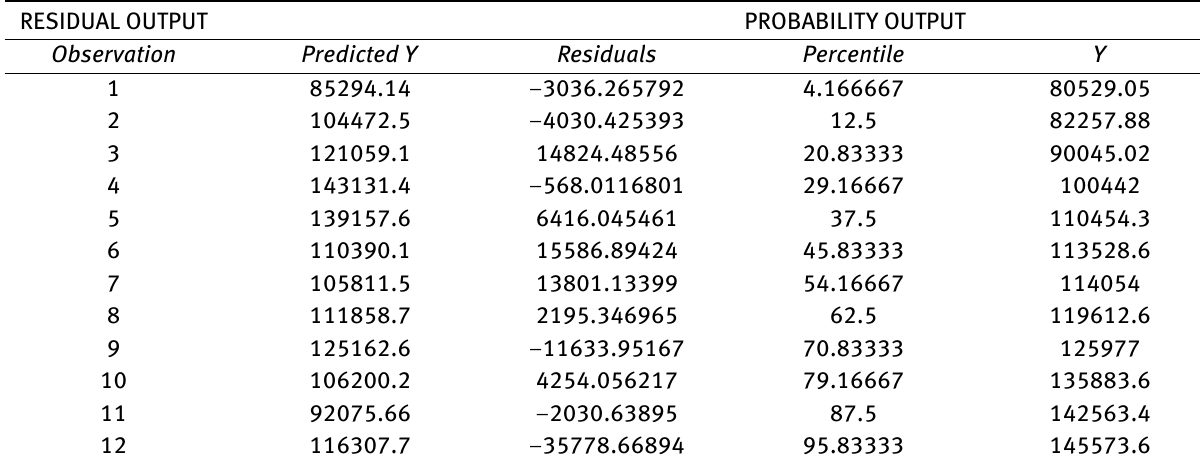
Table 4: Probability Output Vs. Predicted Output